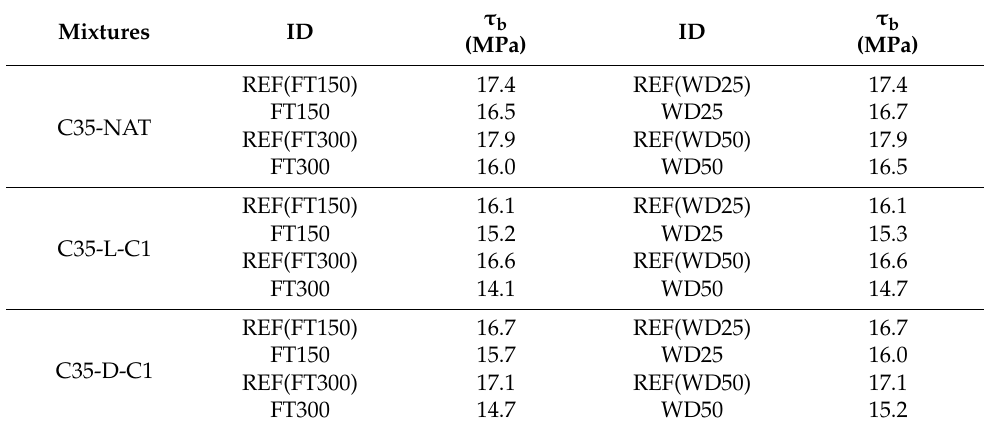
Table 5. Effects of freeze-thaw and wet-dry aging on bond strength of reinforced